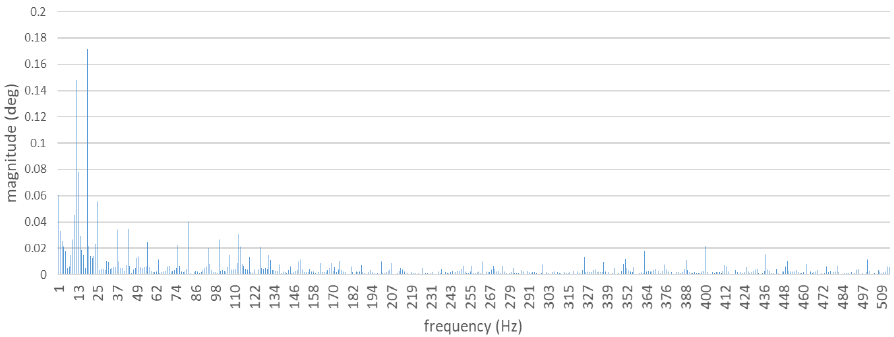
Figure 7. Full spectrum of torsional shaft vibrations. Diesel–electric unit with a defect-free ship engine.